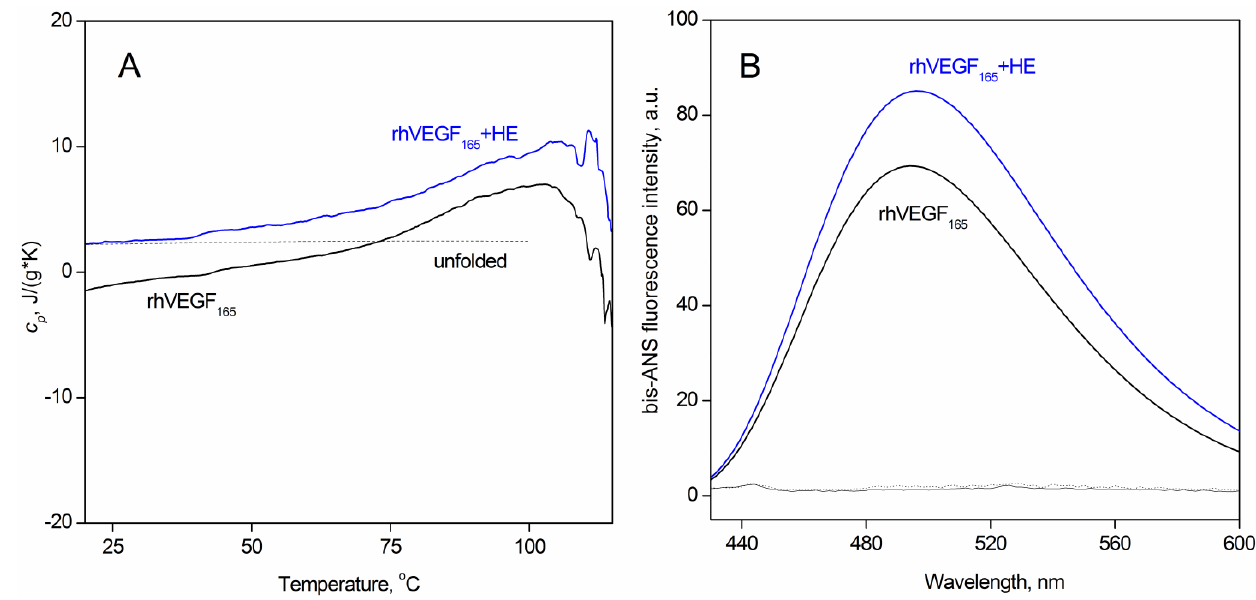
Figure 1. ( A ) Temperature dependencies of specific heat capacity for rhVEGF 165 (1 µM) in the absence (blue line) and the presence of 3.8 µM HE (black line). Grey dashed line corresponds to unfolded VEGF 165 , calculated according to [38]; ( B ) Fluorescence spectra of bis-ANS (2.5 μM) in the absence (black line) and in the presence of heparin (blue line) in the solution containing 2.5 μM rhVEGF 165, monitored by fluorescence emission spectrum of the dye at 25 °C. Thin solid and dashed lines correspond to spectra of bis-ANS in buffer in the presence (grey line) or absence (dashed line) of HE. Buffer conditions: 10 mM Na-phosphate, 50 mM NaCl, pH 7.4.